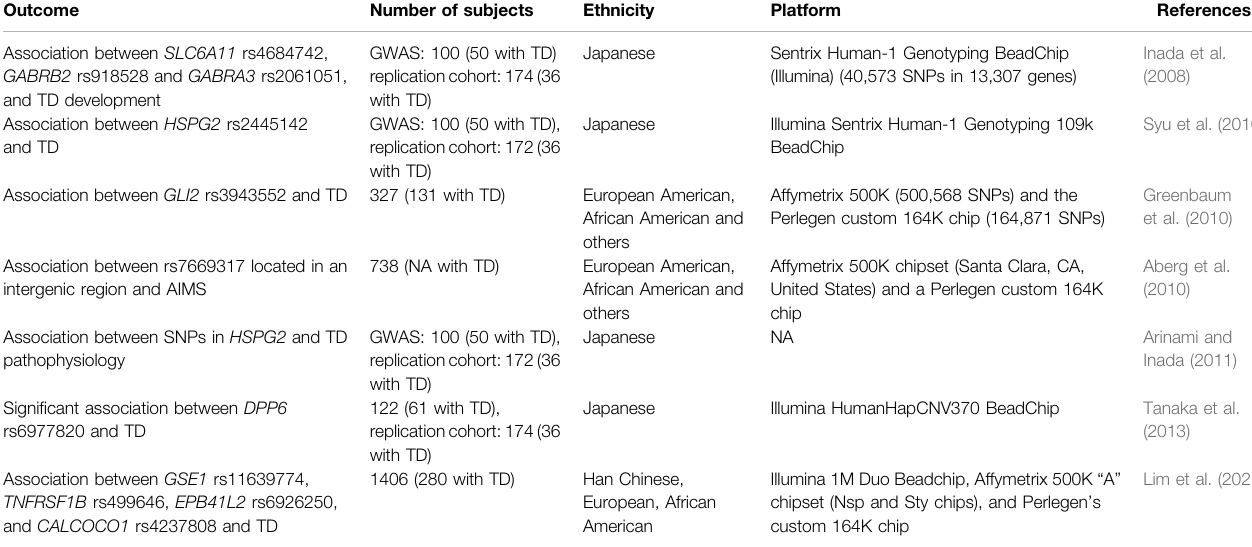
TABLE 11 | Genome-wide association studies of